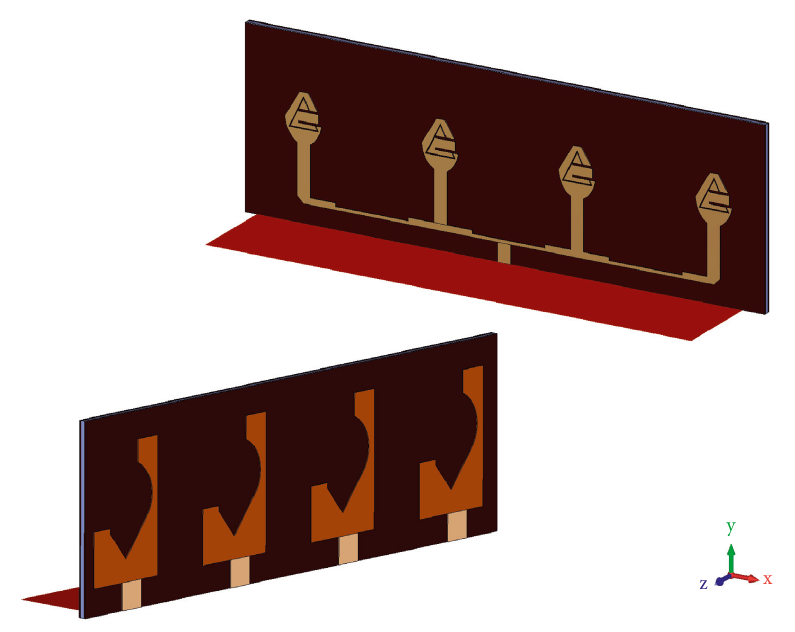
Figure 16: 1 × 4 array